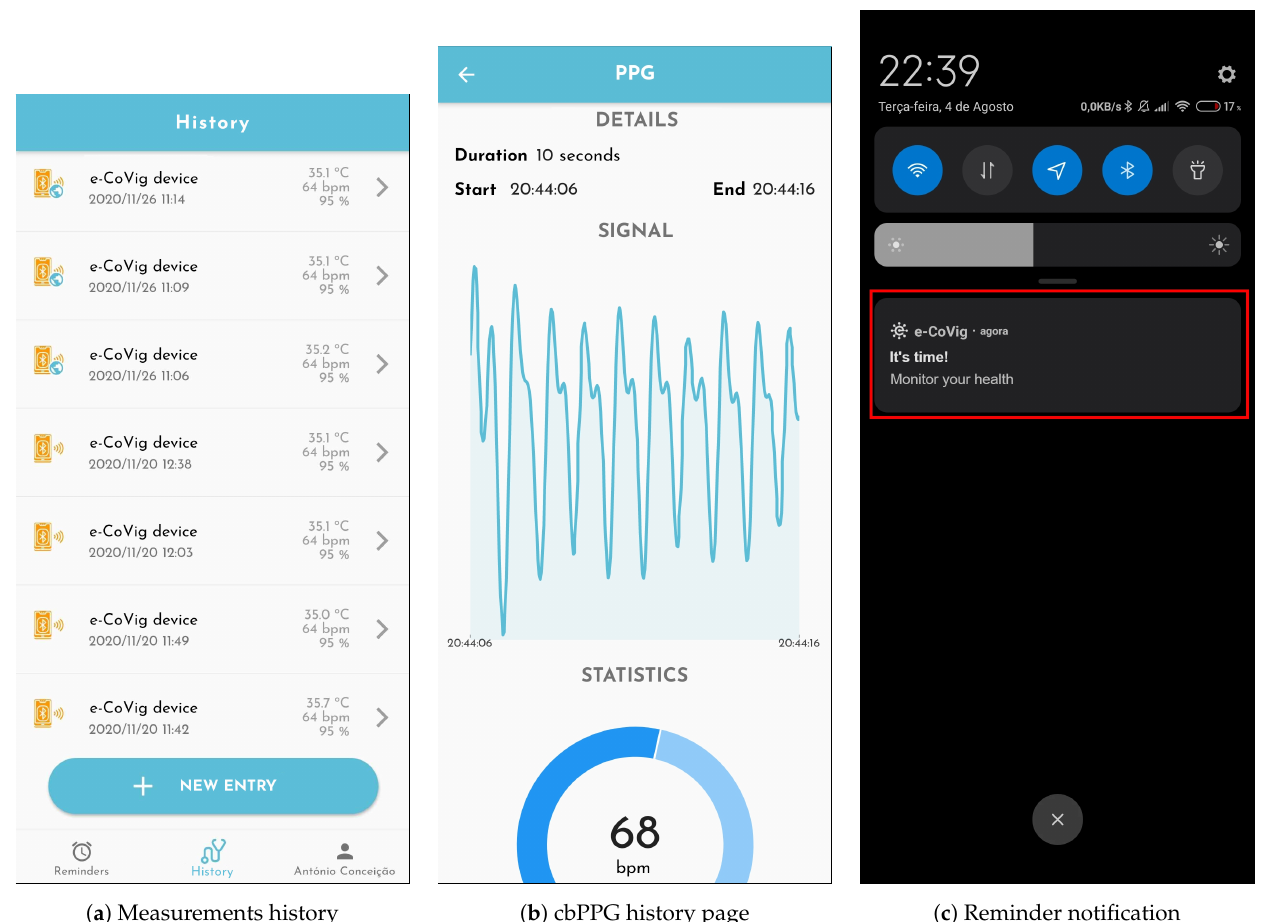
Figure 7. Measurement, history, and